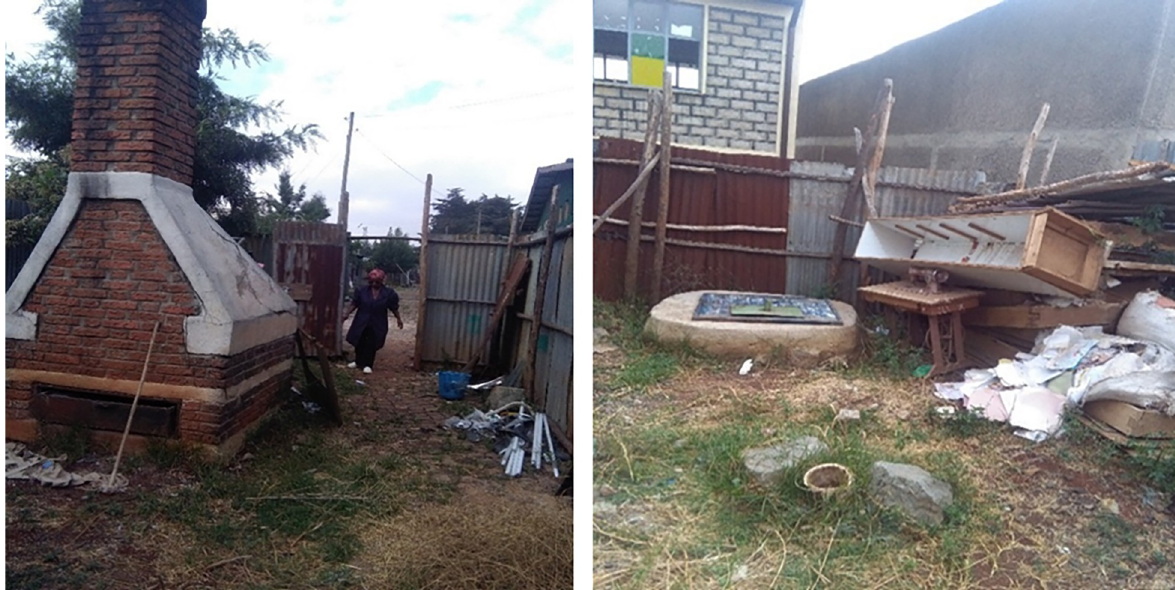
Fig 10. Incinerator (a) and placenta pit (b) with no fencing in one of the study health centres, Addis Ababa City Administration, February 2018.